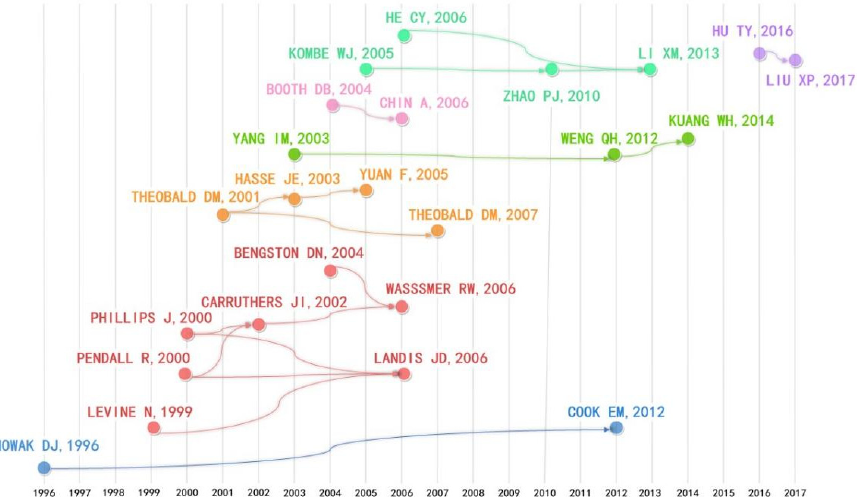
Figure 8. Historical direct citation network of authors of the top 24 most cited papers in urban land management from 1979 to 2021. Table 4. Top 10 LCS publications in urban land management from 1979 to 2021. Publications